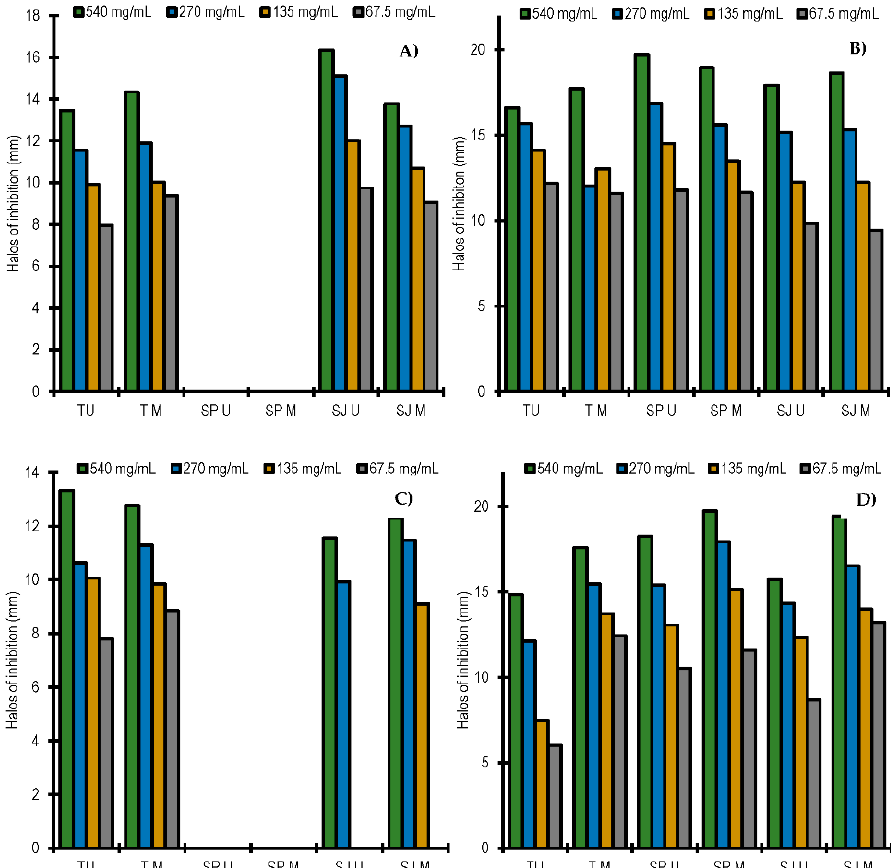
Figure 2. Inhibitory activity of propolis extracts against different microbial strains. ( A ) Staphylococcus aureus (ATCC 13709), ( B ) Candida albicans (ATCC 1023), ( C ) Escherichia coli (ATCC 25922) and ( D ) Salmonella typhimurium (ATCC 43971).